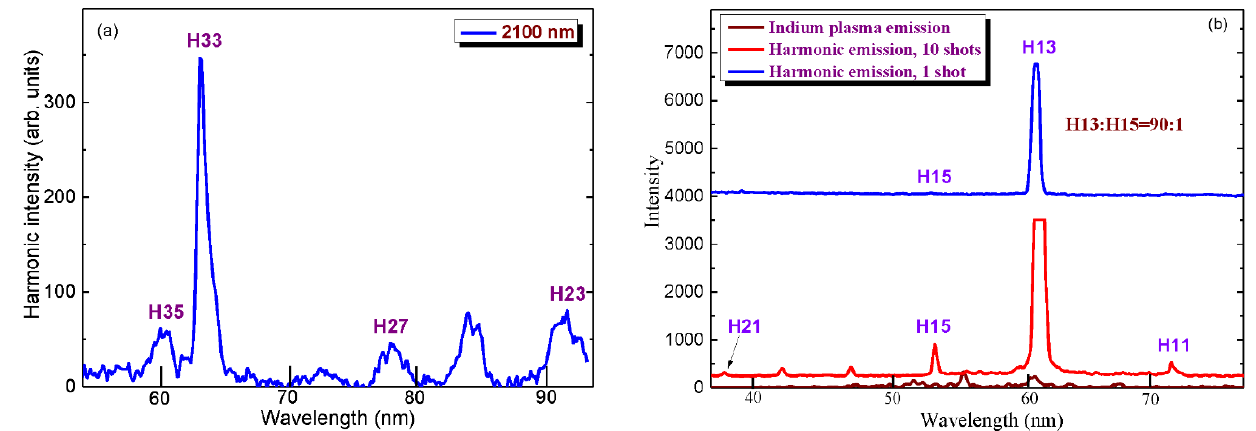
Figure 7. ( a ) Harmonic distribution from In LIP in the 55–95 nm spectral range in the case of 2100 nm PP (Laser2). ( b ) Determination of the enhancement factor of H13 in the case of 800 nm SCP (Laser1). Two upper curves show the same spectrum retrieved at different collection times to demonstrate the saturated H13 emission (middle curve) and unsaturated H13 emission using a different number of laser shots (10 and 1, respectively). Bottom curve shows the plasma emission spectrum of the over-excited indium LIP.